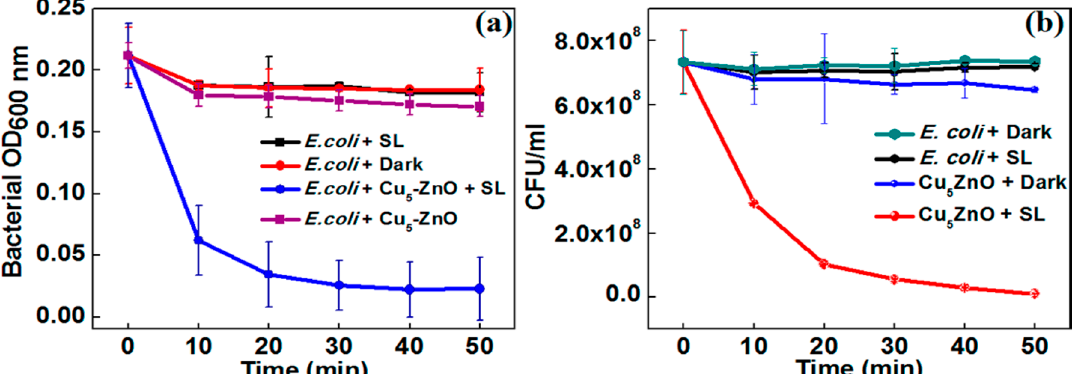
Figure 36. Photoinactivation of E. coli treated with Cu5 / ZnO (200 µ g / mL) under solar light (SL). The plots of ( a ) OD600 and ( b ) CFU / mL as a function of time. The experiments were performed in triplicates and data were expressed as the mean ± SD. Reproduced from [102] with permission of the American Chemical Society.